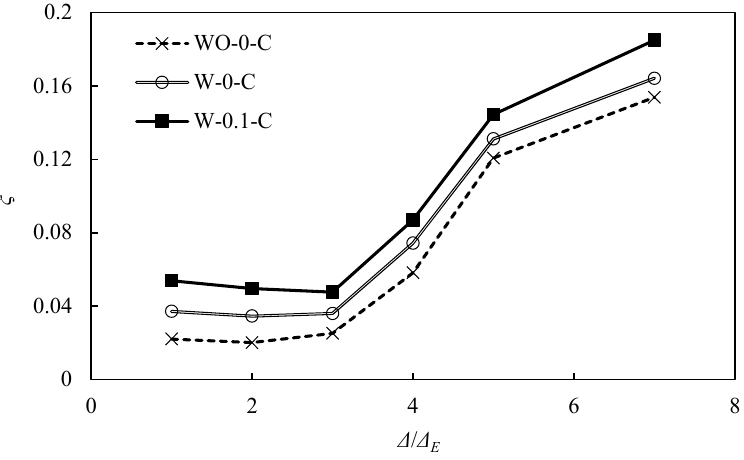
Figure 8. Equivalent damping coefficient of the SDI specimens.